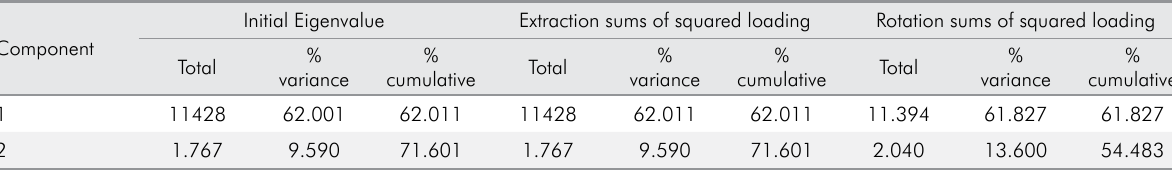
Table 4. Total variance explained for two DTMS components